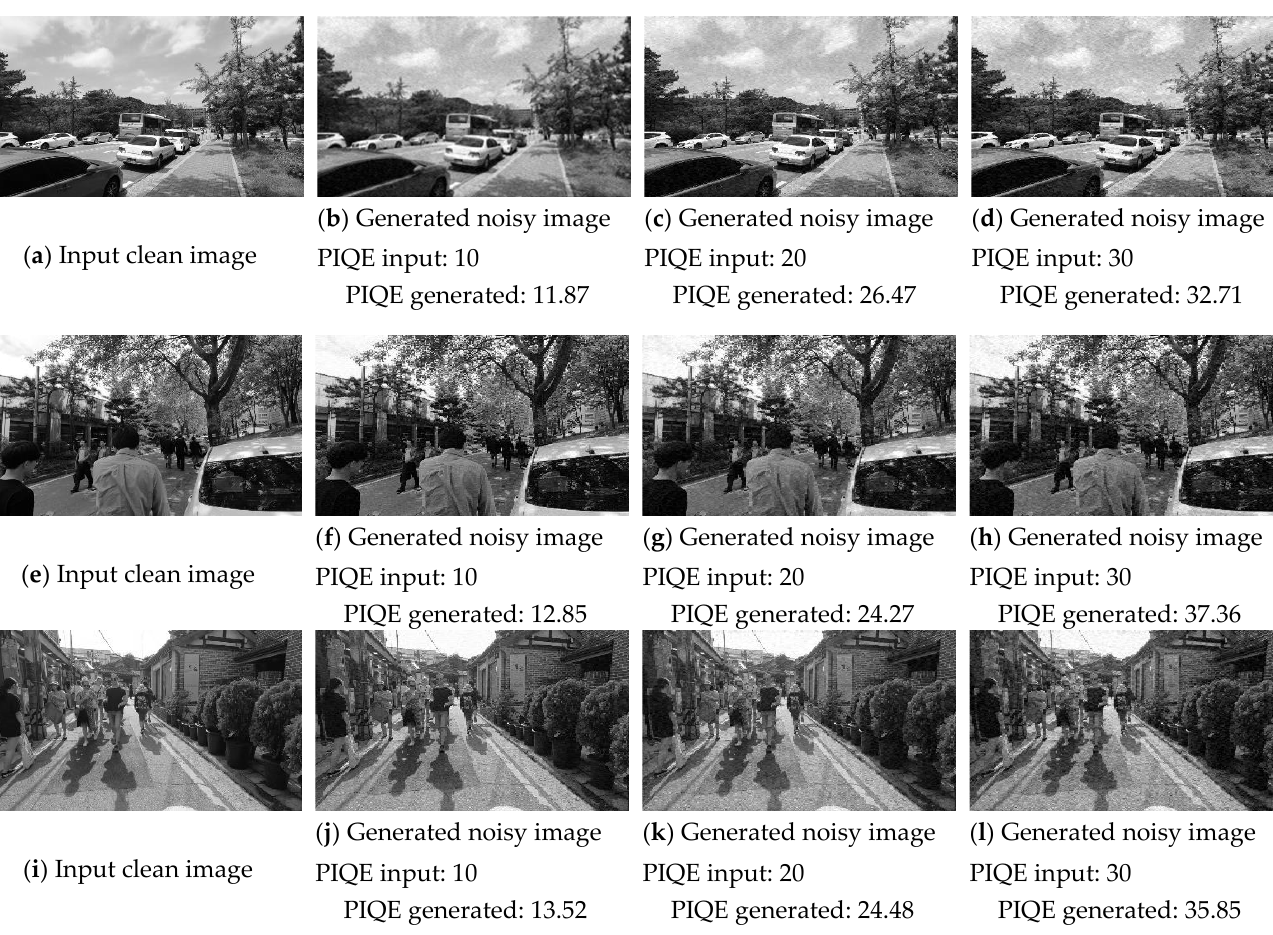
Figure 9. Effectiveness of various PIQE values as input for the generator. ( a , e , f ) are the clean images from REDS dataset. ( b – d ), ( f – h ), and ( j – l ) are the images generated by the proposed model with different PIQE values as an input.